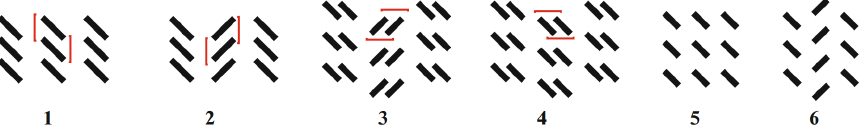
Figure 1. Canonical types of crystal packages of planar conjugate unsaturated molecules; the seg- ments represent lateral projections of planar conjugate unsaturated molecules, while the brackets show parallel dimer pairs. Reprinted from [147], with permission from Springer Nature.